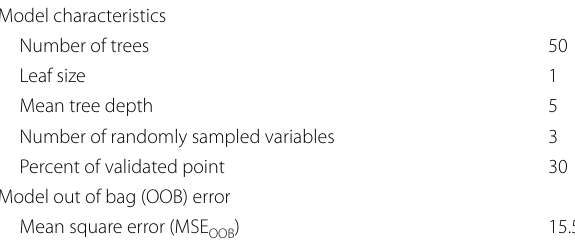
Table 4 RF model characteristics associated with